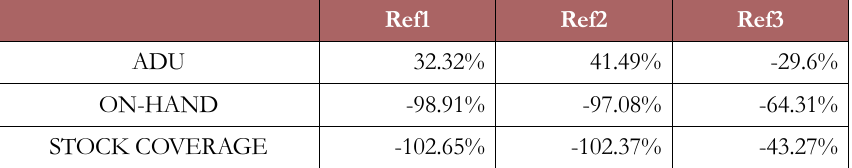
Table 1. Evolution of the analyzed 3 most consumed goods of the same